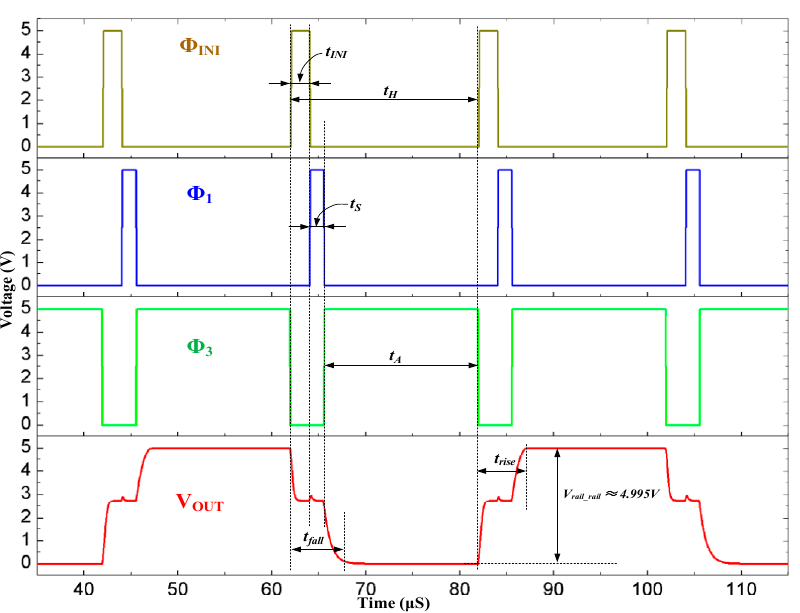
Figure 8. The simulated transient response of our proposed buffer-reused 10-bit DAC.